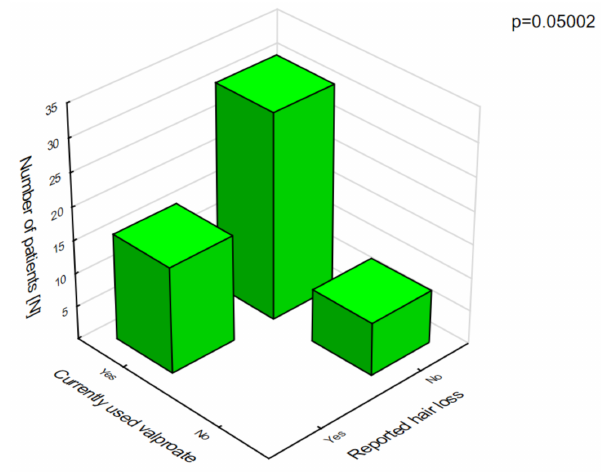
Figure 5. Valproic acid and hair loss.